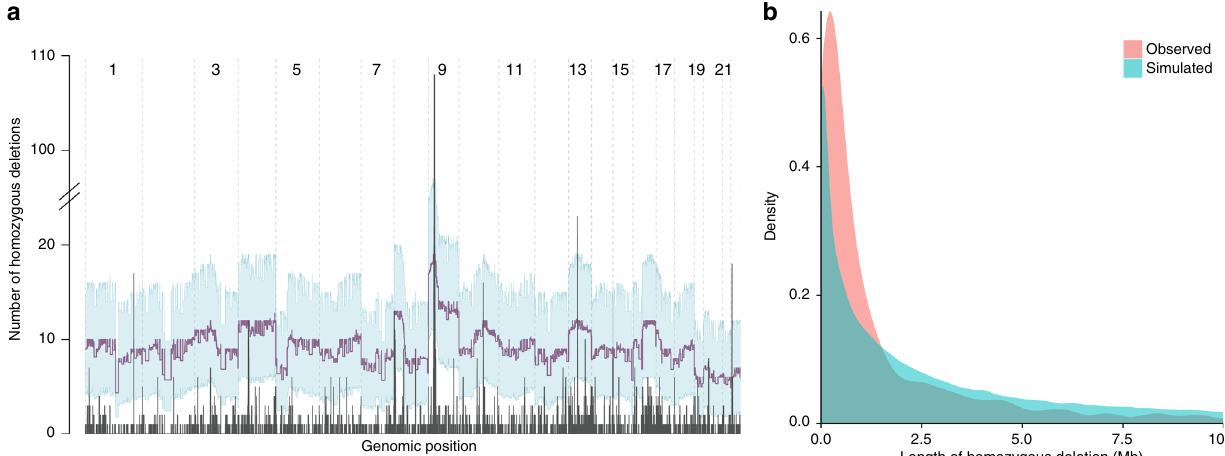
Fig. 2 Homozygous deletions are non-randomly distributed across the genome. a Genomic distribution of the frequency of homozygous deletions (dark grey). Permutation test results, modelling homozygous deletions as a combination of two independent loss-of-heterozygosity events, are overlaid (mean and 95% con fi dence intervals in purple and light blue, respectively), indicating that homozygous deletions are strongly depleted across the genome due to negative selection. b Size distribution of homozygous deletions as observed and as predicted by the model above, indicating stronger negative